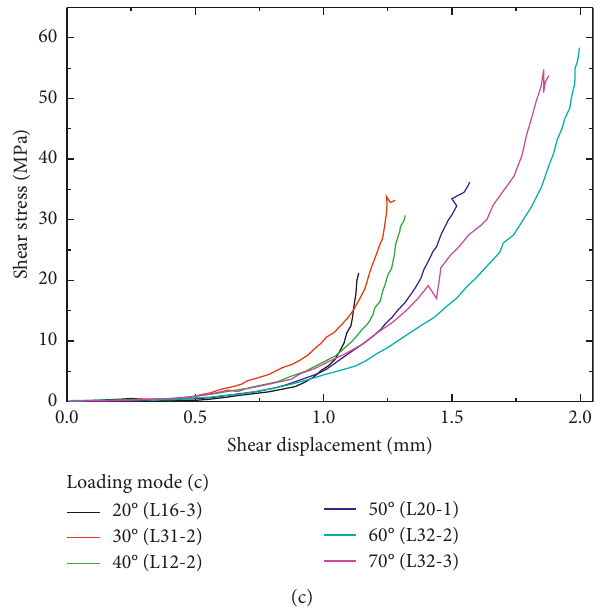
Figure 6: Shear stress vs displacement curves under loading modes: (a), (b), and (c).